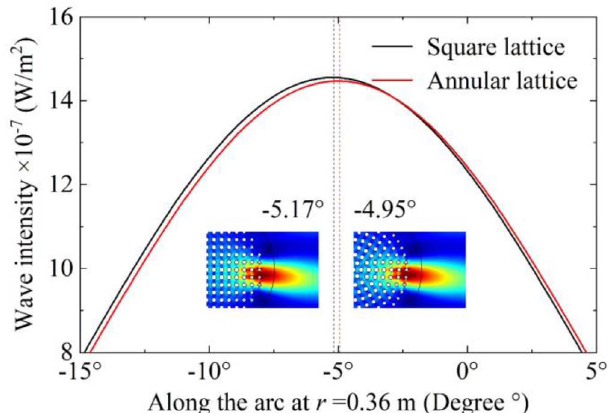
Figure 11. The focusing angles of square-lattice and annular- lattice Luneburg lens when the incident angle and frequency are 5 (cid:1) and 5500 Hz,